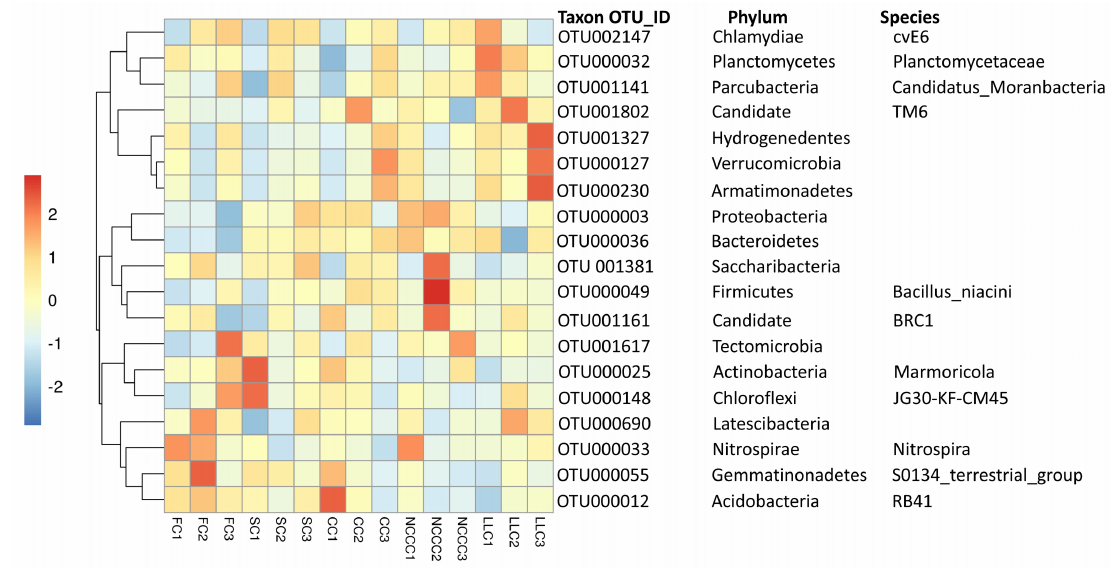
Figure 2. Heatmap analysis of abundant bacterial taxon under different planting system.